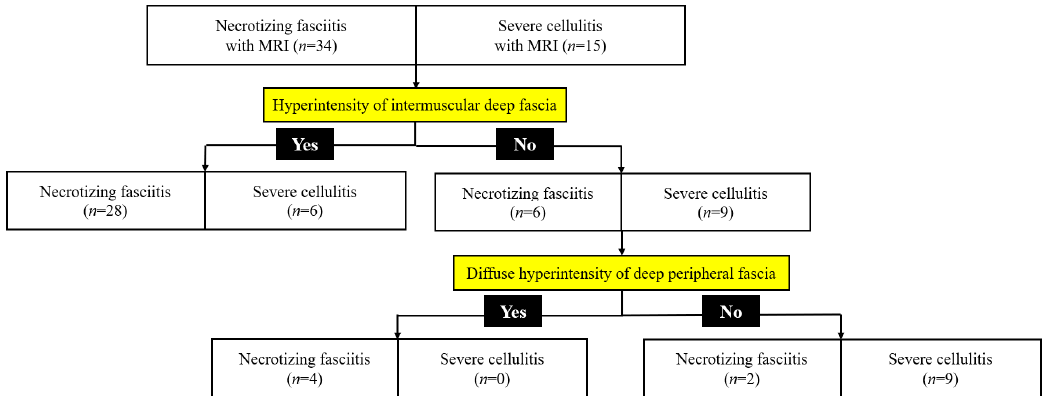
Figure 4. Magnetic resonance indicator for necrotizing fasciitis (MRINEC) algorithm for di ff erentiating necrotizing fasciitis from severe cellulitis. Abbreviations: MRI = magnetic resonance imaging. Table 4. Diagnostic performance of the magnetic resonance indicator for necrotizing fasciitis (MRINEC) algorithm.